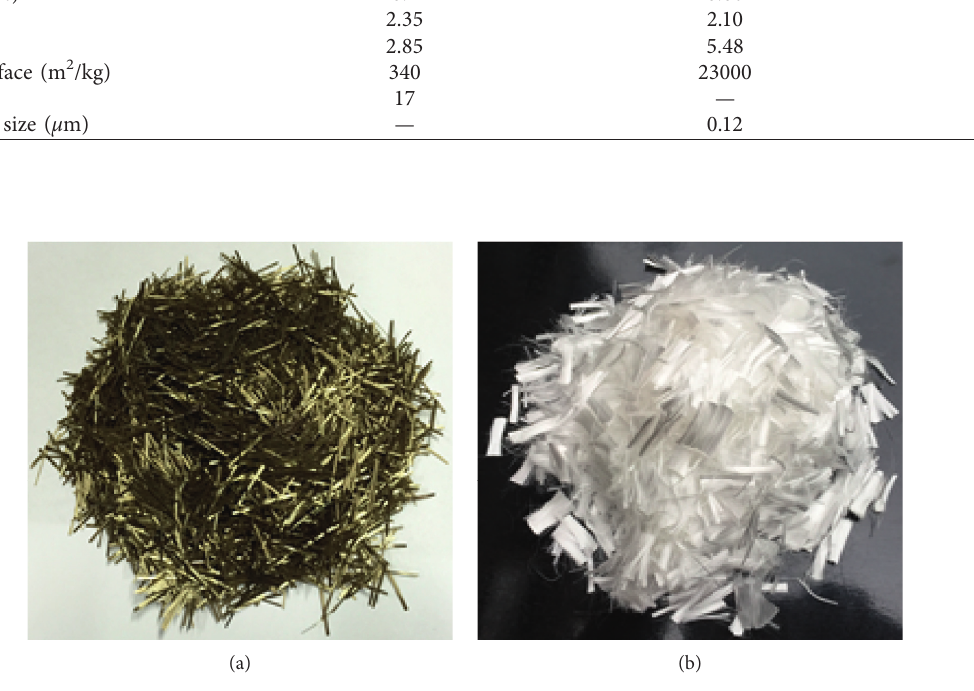
Figure 1: Morphology of fibers. (a) Basalt fiber. (b) Polypropylene fiber.